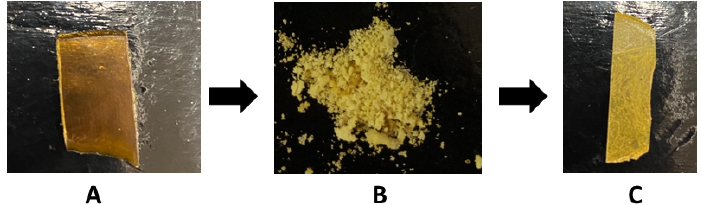
Figure 13. Reprocess cycle of the material 5050DSS. ( A ): Pristine sample. ( B ): Grinded sample. ( C ): Recycled sample.